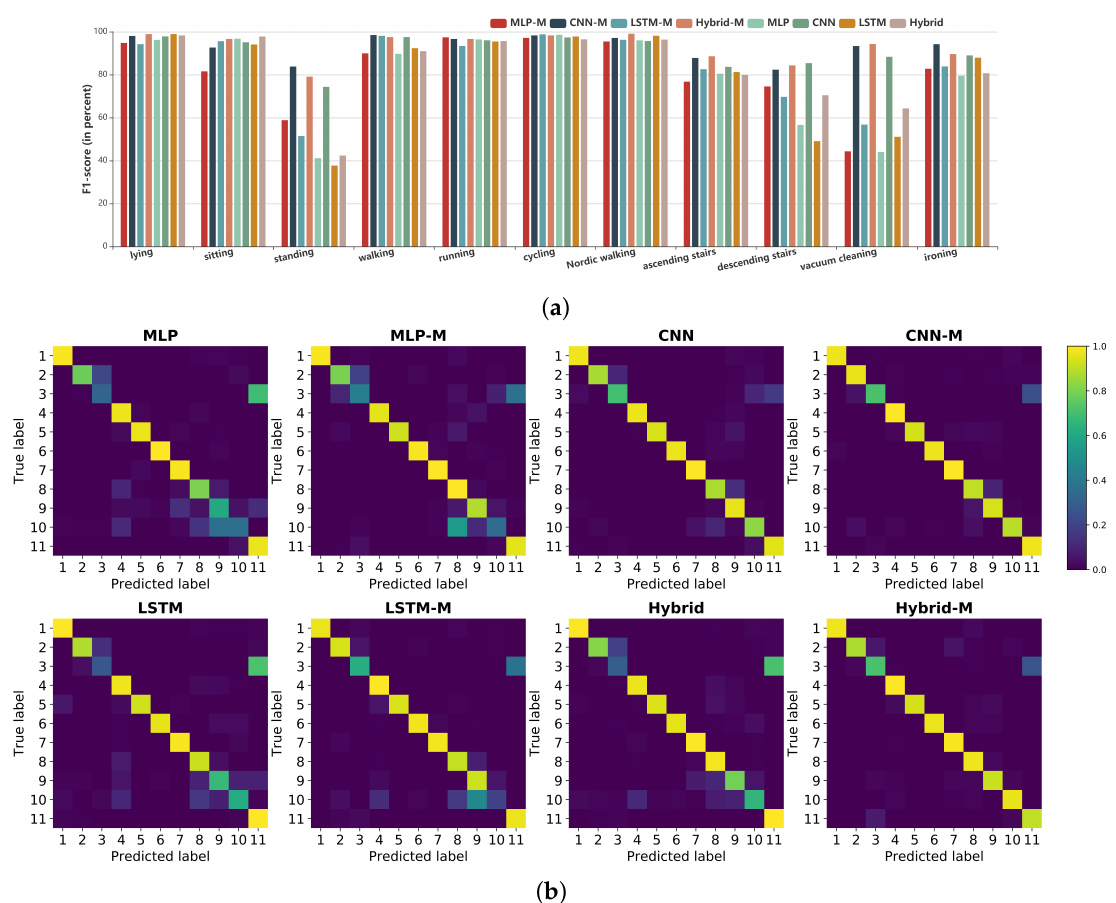
Figure 4. ( a ) The F1-score (in percent) of each class of different models on the PAMAP2 dataset. ( b ) Confusion matrix of each model on the PAMAP2 dataset. The horizontal and vertical axes represent the predicted and true classes, respectively. 1, lying; 2, sitting; 3, standing; 4, walking; 5, running; 6, cycling; 7, Nordic walking; 8, ascending stairs; 9, descending stairs; 10, vacuum cleaning; 11,